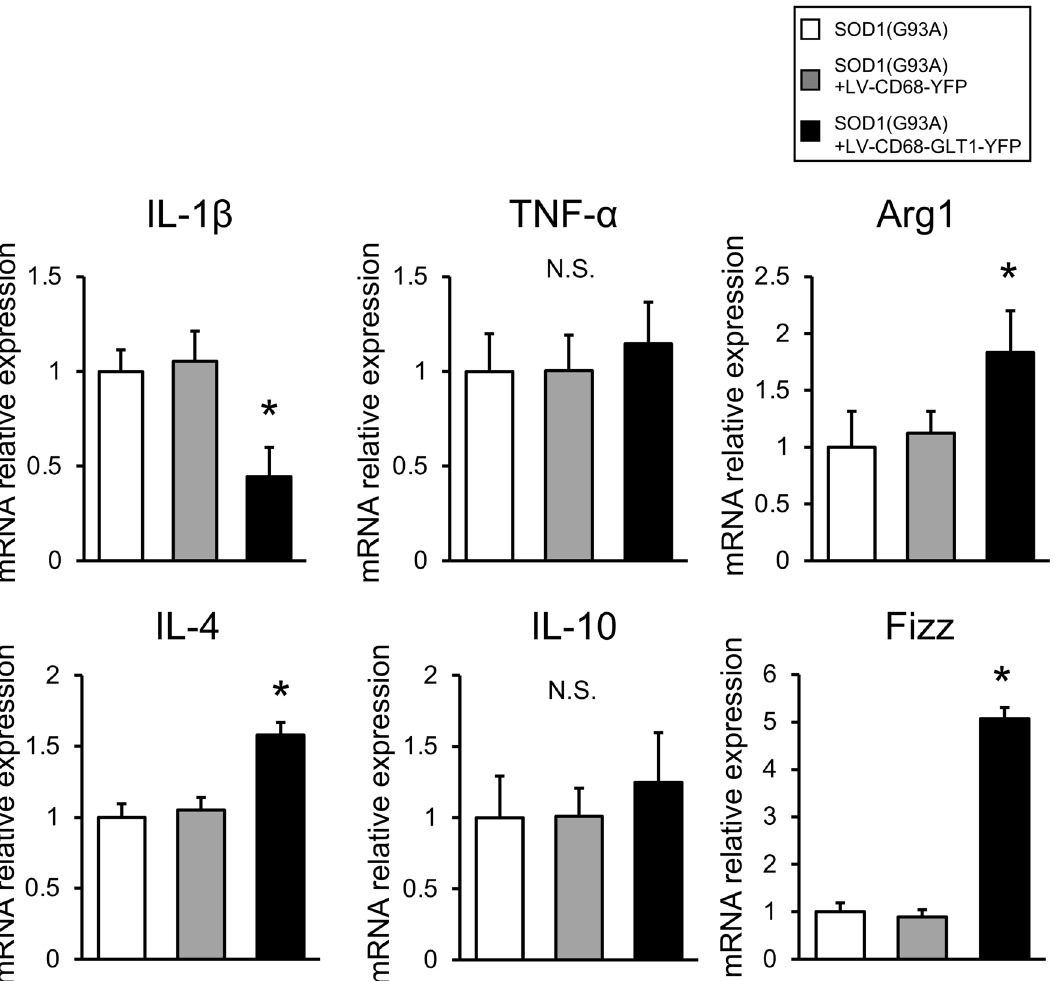
SOD1(G93A) + LV-CD68-YFP and SOD1(G93A) + LV-CD68-GLT1-YFP groups at 18–20-week-old (n = 5 each group). Data were normalized to GAPDH mRNA expression. Error bars represent the mean + SD. *p < 0.05 between the treatment group and